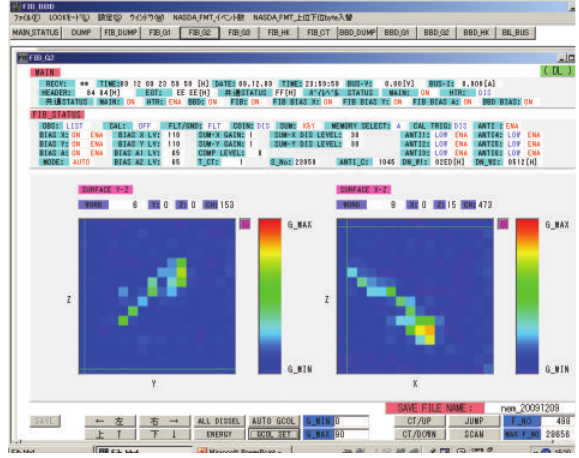
Figure 5: A typical background neutron event. The neutrons enter from the preceding section of the ISS (small to large in the horizontal scale y of the left side picture) and from the top to the bottom (small to large of the right side picture x in horizontal axis). The incident neutrons are converted into protons inside the scintillator. The energy deposit in each bar is color-coded. At the termination point of the track, the Bragg peak can be recognized. The G min and G max correspond to the ADC channel 0 and 90. The linear ADC has a range of 256 channels and the dip and peak correspond to 11 (dark blue) and 22 (light blue) respectively induced by the minimum ionizing particles. Orange spot corresponds to about channel